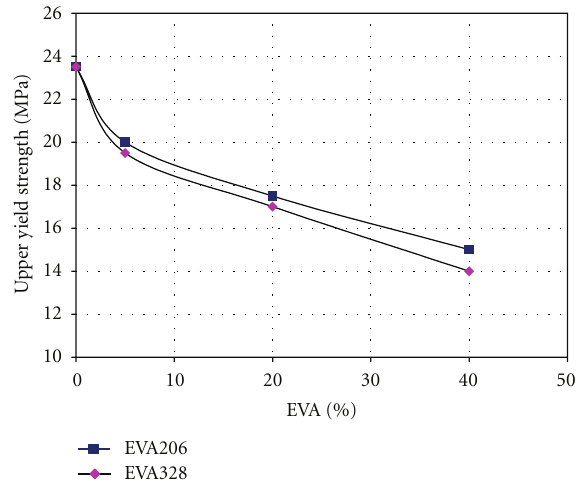
Figure 10: Variation of HDPE/EVA blends modulus with EVA contents and type.